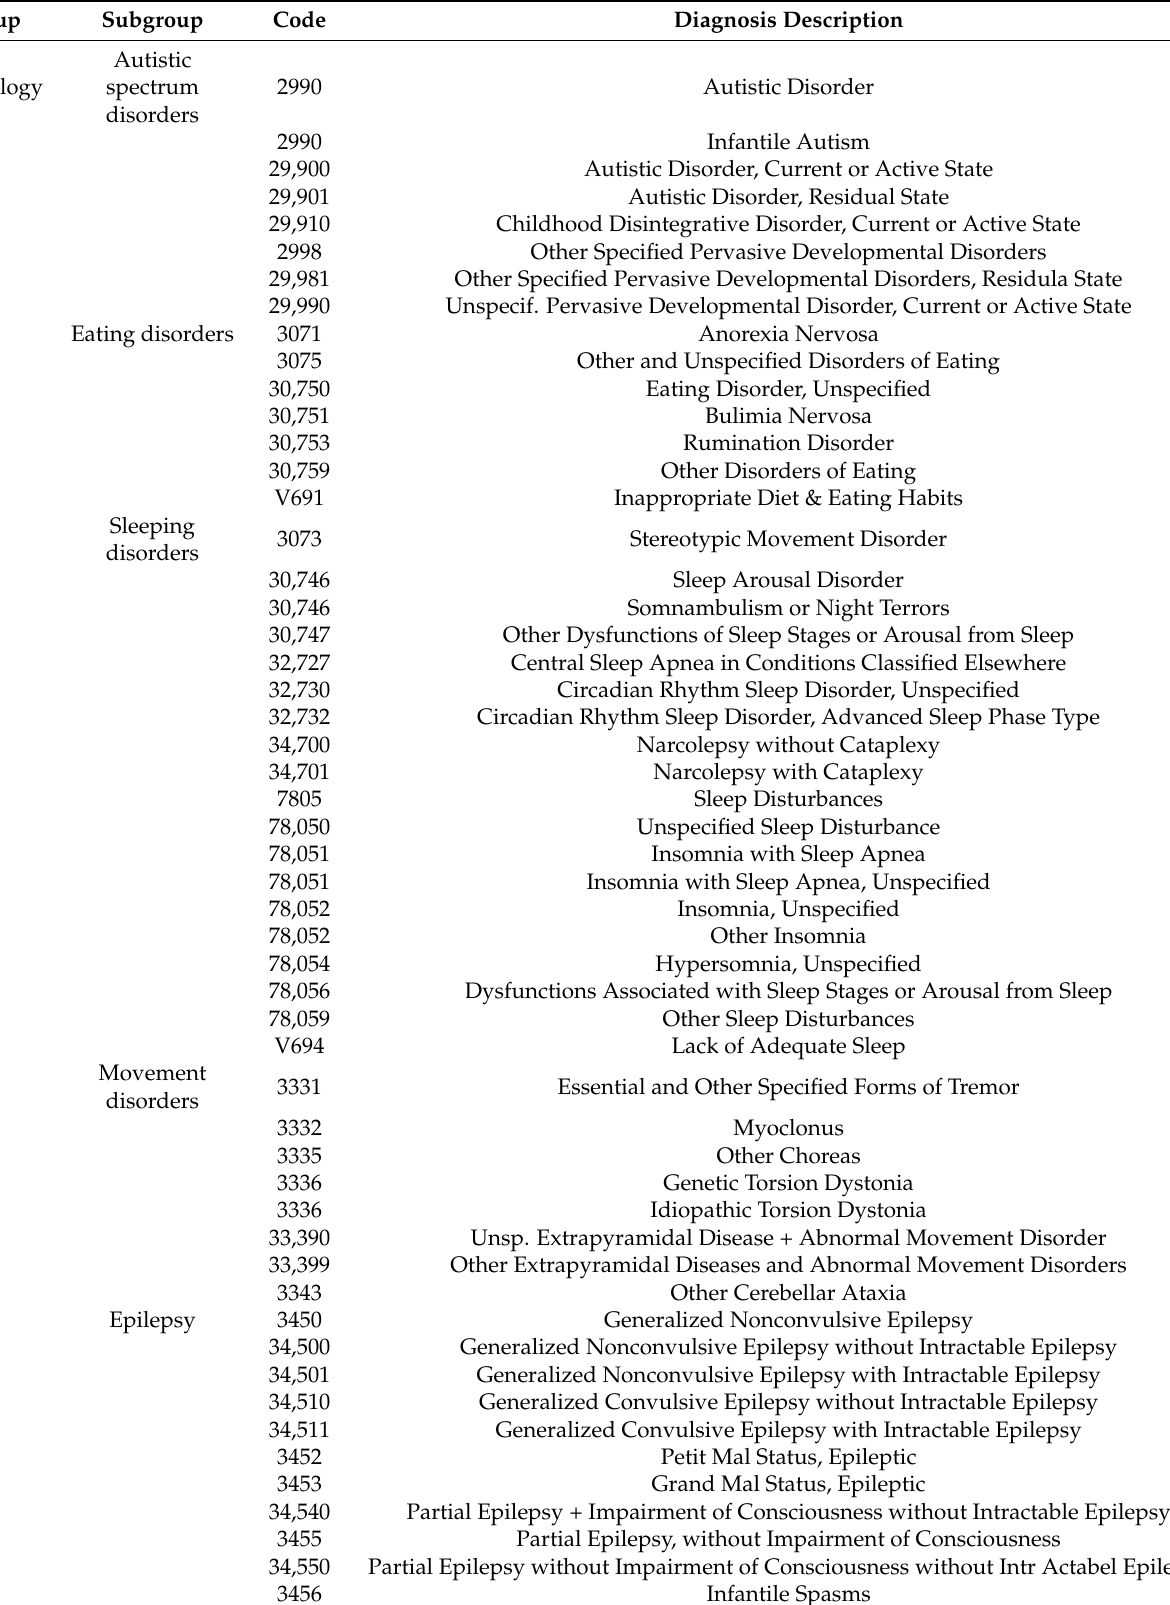
Table A1. Supplement A-Table—List of Neurological